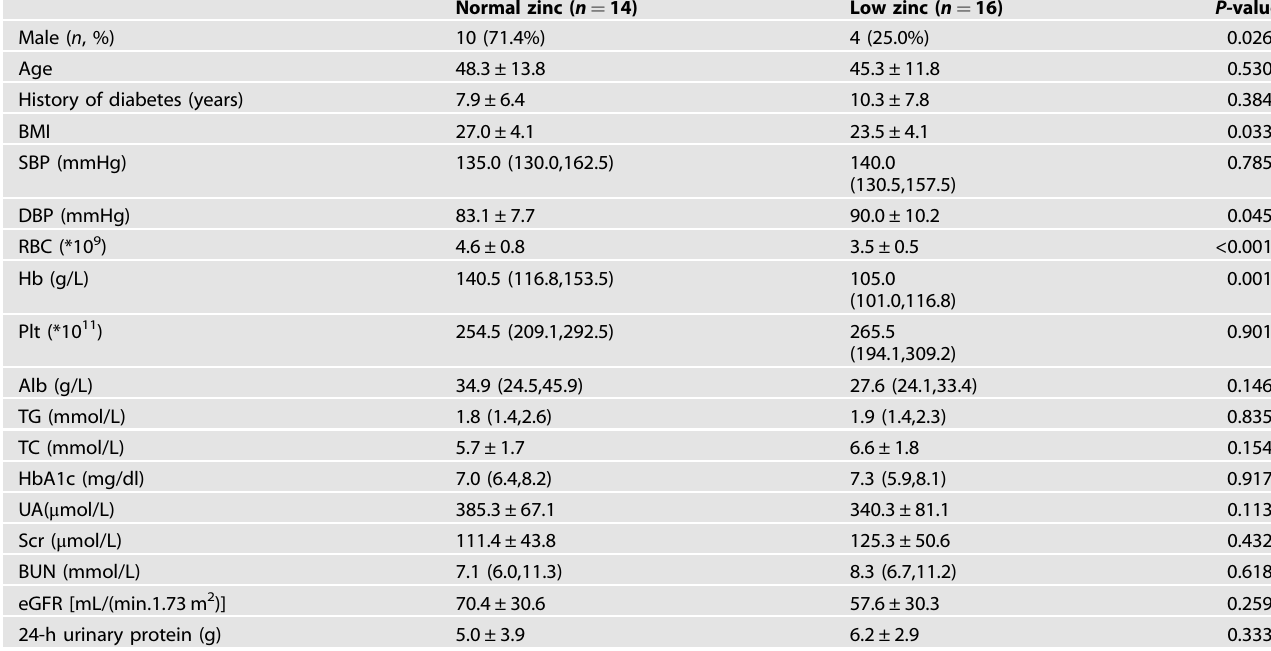
Table 1. Clinical data of low-zinc and normal-zinc groups.